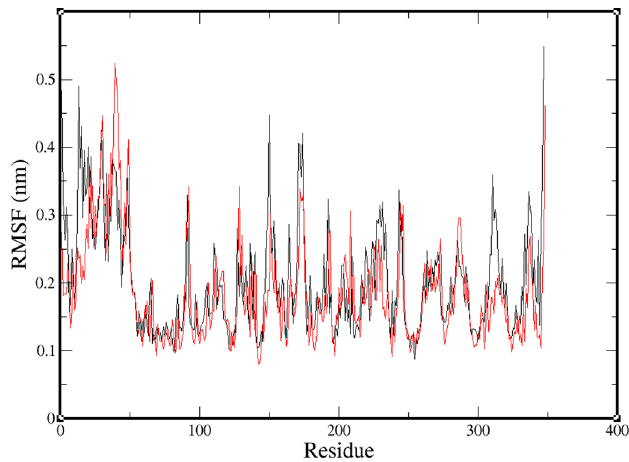
Figure 4. Representation of root mean square fluctuation (RMSF) of each complex. Black, NuBBE- 1970–NSP15 complex fluctuations; red, NuBBE-242–NSP15 complex fluctuations.